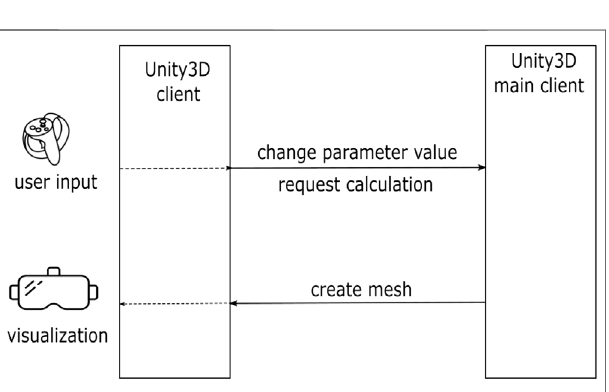
FIGURE 10 | RPC exchanges between the main Unity3D client and all other clients in BIMFlexi-VR.